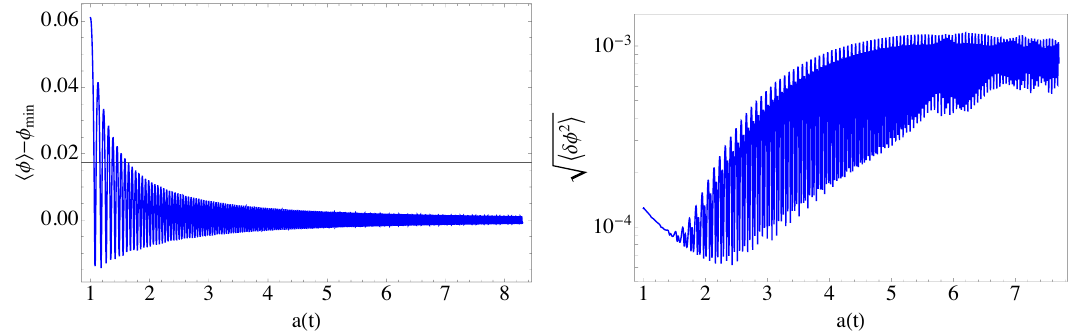
(cid:0) 5 with 512 3 lattice Figure 6 . Results from a lattice simulation of the KKLT model with W 0 = 10 points. Top: the homogeneous mode (cid:30) ( t ) as a function of the scale factor a ( t ). The solid black line marks the (cid:12)eld value at the in(cid:13)ection point of the potential (cid:30) inf . One can see that only the (cid:12)rst p h (cid:14)(cid:30) 2 i as a function of the scale factor a ( t ). three oscillations are tachyonic. Bottom: the variance The dynamics start showing non-linear e(cid:11)ects when the amplitude of the homogeneous component h (cid:30) i becomes comparable to the variance at a (cid:24) 5.